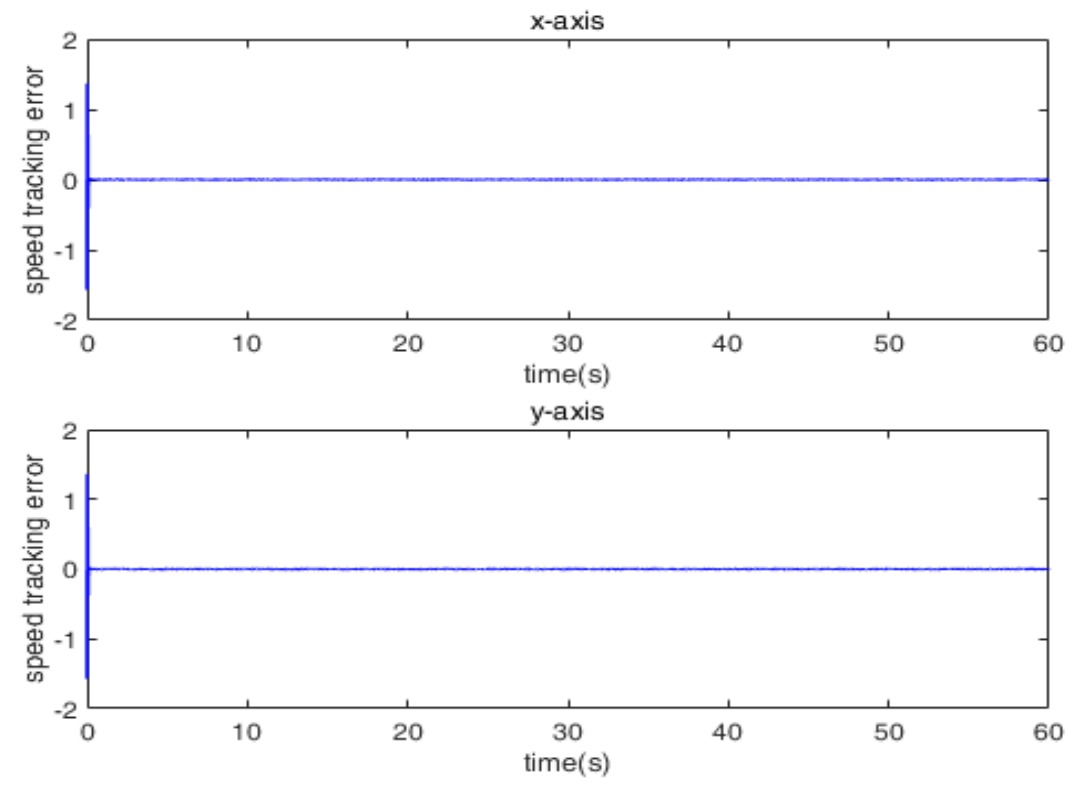
Figure 7. Position tracking error under NFTSMC ‐ GRFNN.